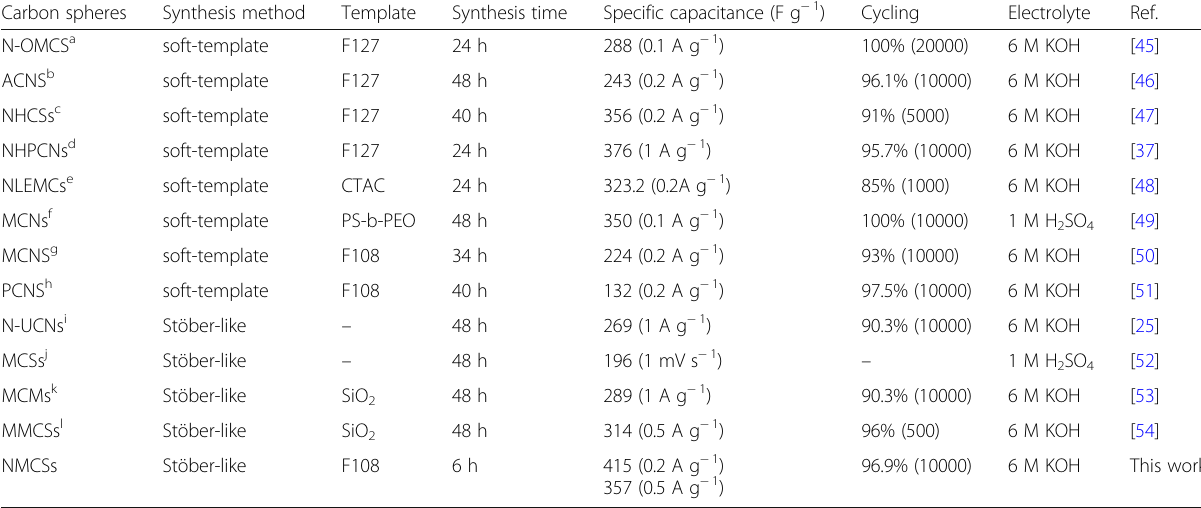
Table 3 Comparison of synthesis time and electrochemical performances of CSs synthesized by soft-template or Stöber-like methods Carbon spheres Synthesis method Template Synthesis time Specific capacitance (F g − 1 ) Cycling